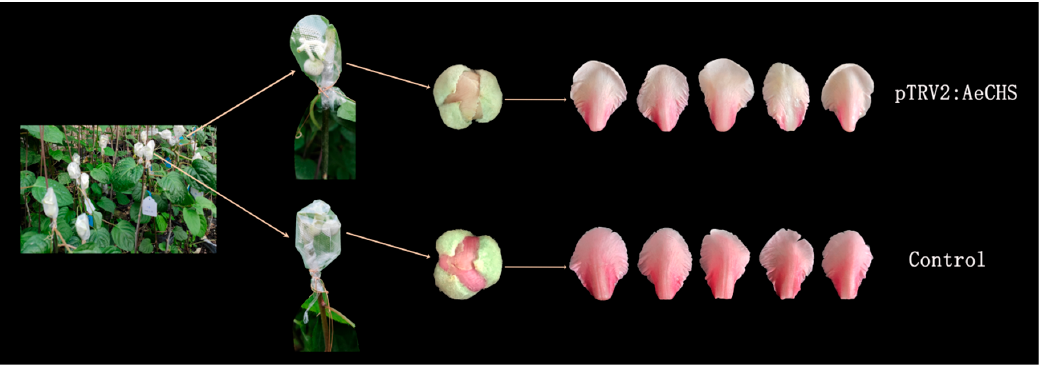
Figure 7. Petals of AeCHS -silenced (upper) and the control (lower) A. eriantha ‘Zaoxu’ flowers. Petals of AeCHS -silenced flowers were of a paler pink than those of the control, and close to white.